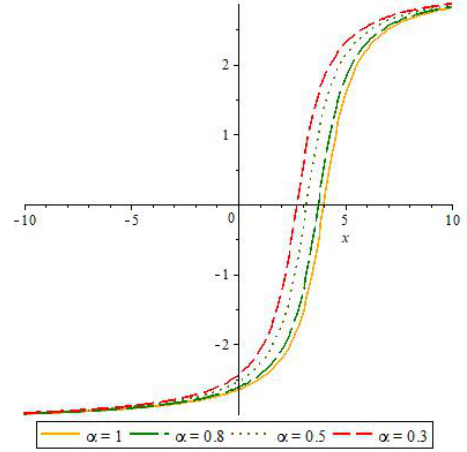
Figure 5. Plots of solutions with different α at y = 0, t =